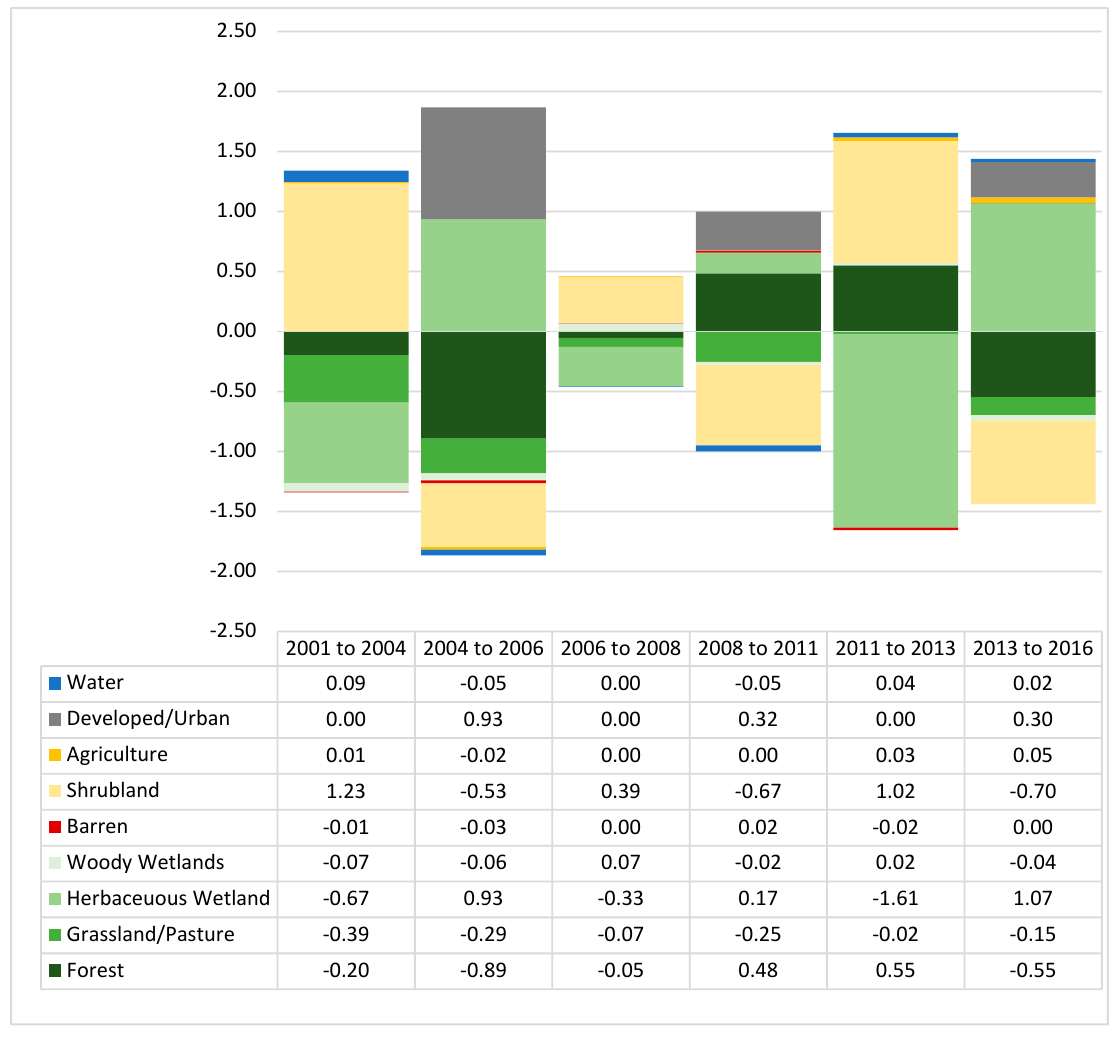
Figure 4. The land cover percent gains/loss shows that vegetated areas such as forest, grassland and herbaceous wetland decreased; while developed/urban areas increased from 2001 to 2016.